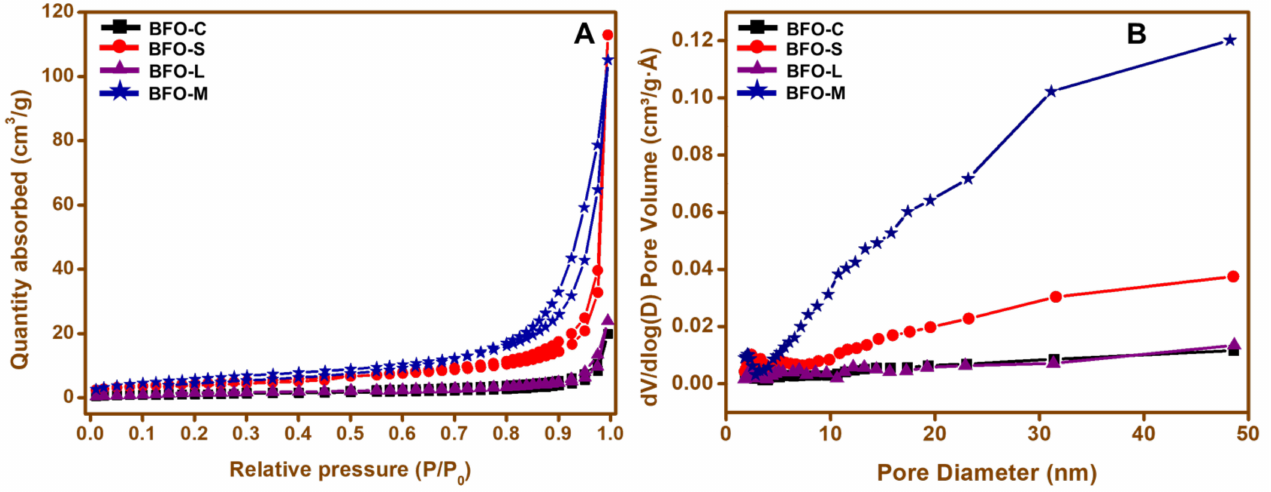
Figure 7. ( A ) N 2 adsorption–desorption isotherm and ( B ) pore volume distribution graph for (a) BFO- C, (b) BFO-S, (c) BFO-L, and (d) BFO-M